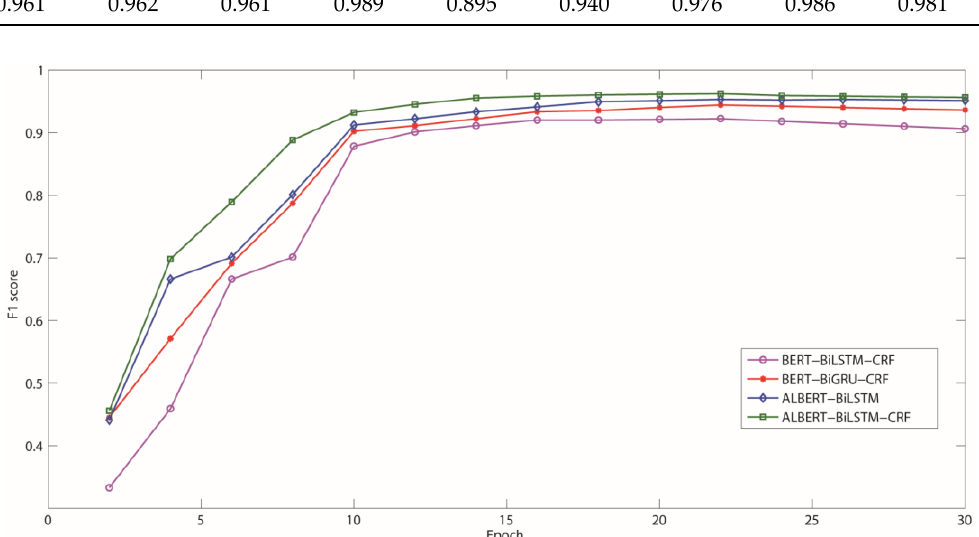
Figure 6. The F1‑scores of each model after hyperparameter Figure 6. The F1-scores of each model after hyperparameter tuning.